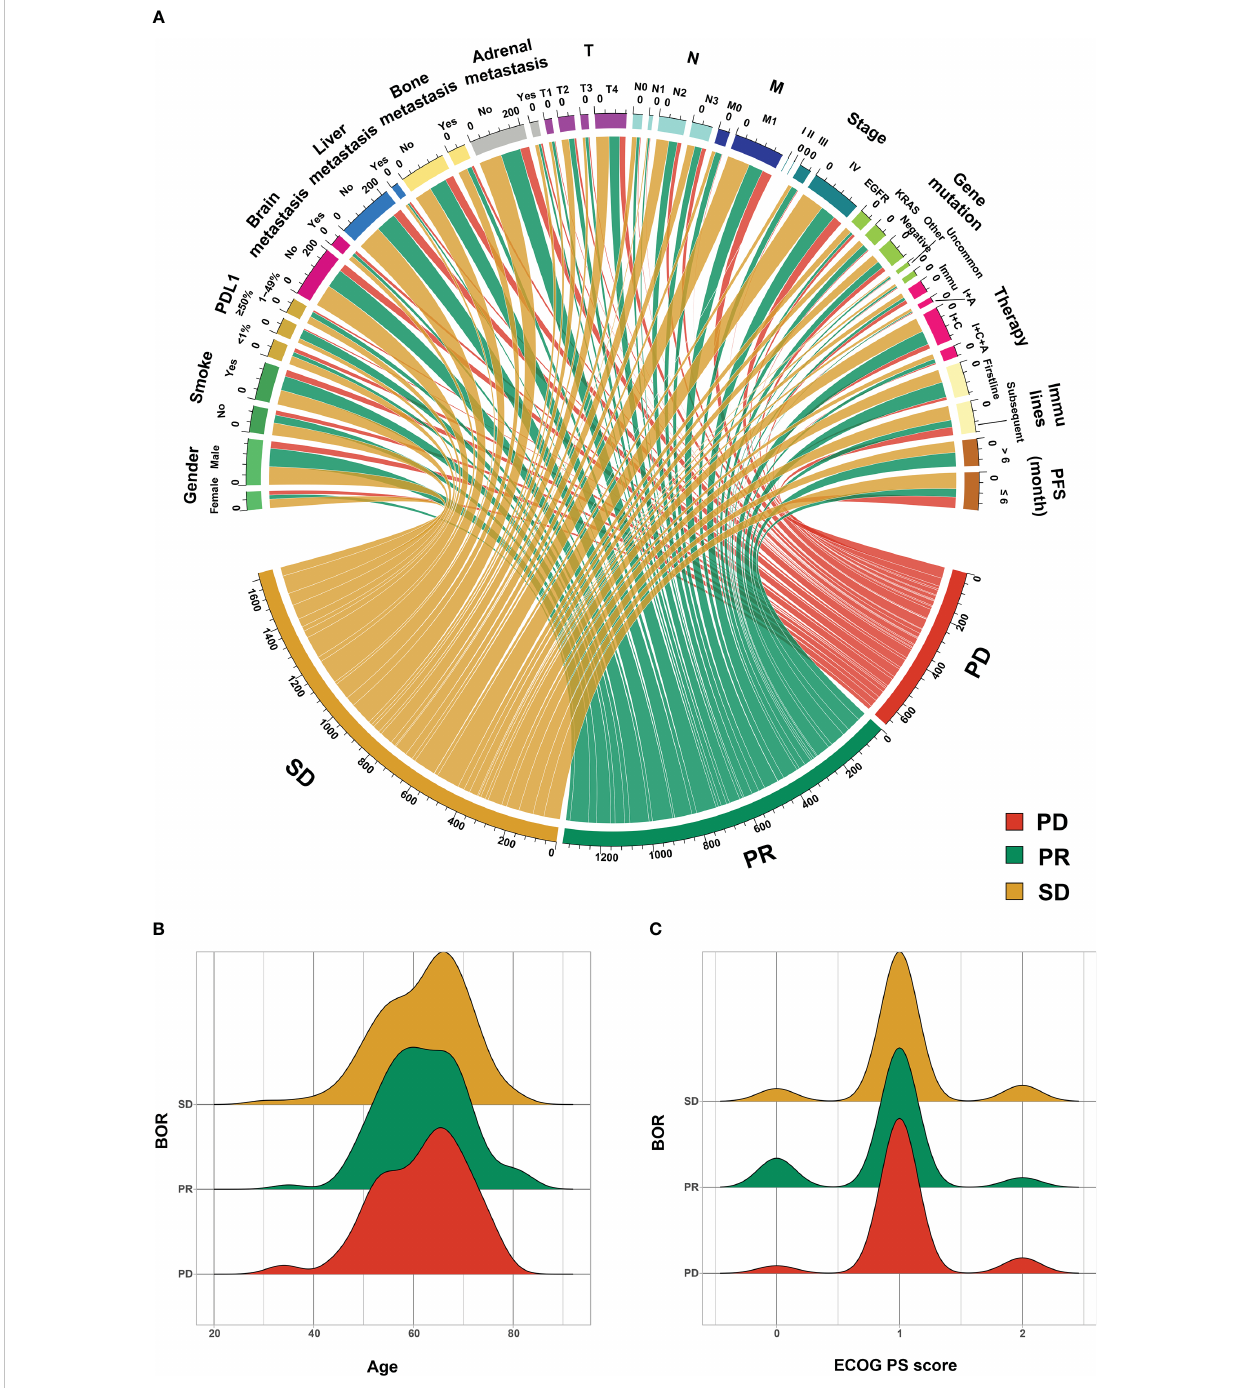
FIGURE 2 The source of progressive disease (PD) partial response (PR) and stable disease (SD) patients. (A) categorical features, (B) age, and (C) Eastern Cooperative Oncology Group (ECOG) performance status score (PS score). PD-L1, programmed cell death ligand 1; Other gene mutation, TP53; Uncommon gene mutation, ALK, ROS1, RET, MET, BRAF, and HER2; Immu, immunotherapy, I+A, immunotherapy and antiangiogenic therapy; I+C, immunotherapy and chemotherapy therapy; I+C+A, immunotherapy, chemotherapy, and antiangiogenic therapy; PFS, progression-free survival; BOR, best of